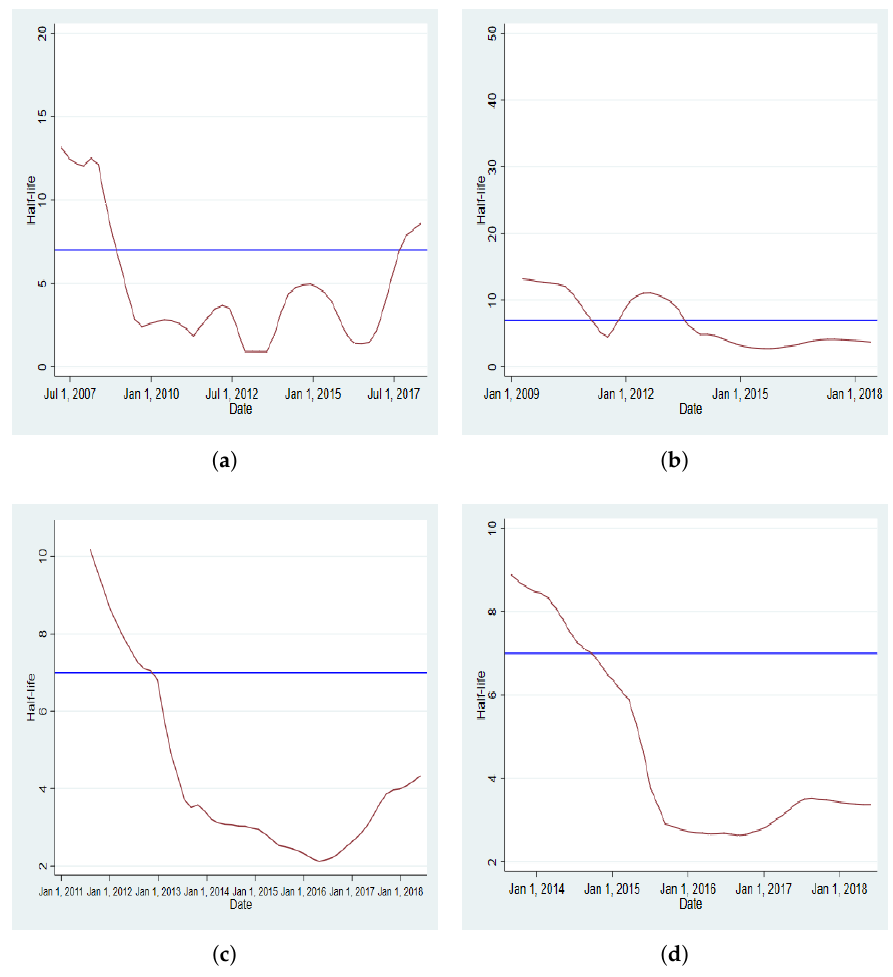
Figure A5. Dynamics of half-time for the BRVMC index using standard rolling regression. These graphs plot the half-time estimated using rolling regression. The date is the end date for a selected window. In ( a ), the half-time is 14 days using recursive rolling regression with a window whose end date is 1 July 2007. ( a ) Dynamics of half-time for the BRVMC index using standard rolling regression with a 2-year window; ( b ) Dynamics of half-time for the BRVMC index using standard rolling regression with a 4-year window; ( c ) Dynamics of half-time for the BRVMC index using standard rolling regression with a 6-year window; ( d ) Dynamics of half-time for the BRVMC index using standard rolling regression with an 8-year